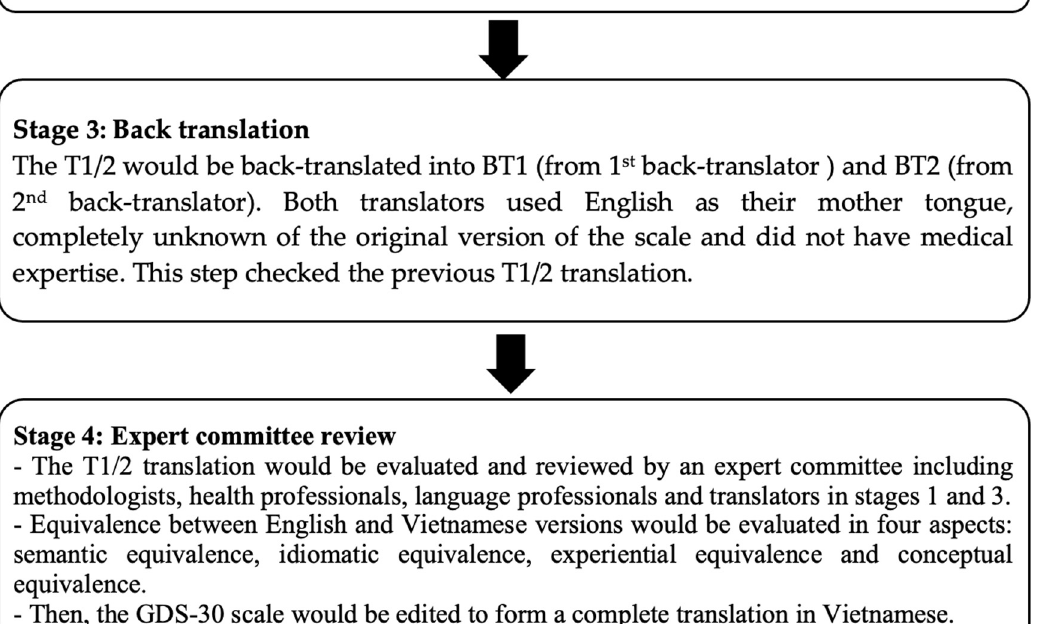
Figure 1. Translation and cross-cultural adaptation.